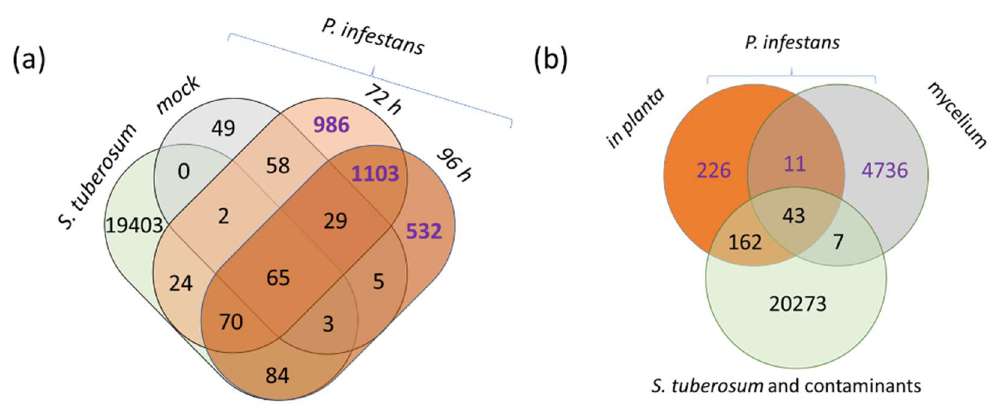
Figure 6. Venn diagram representation of identified peptides in inoculated detached leaves ( a ) and in leaves from the field experiment ( b ). Mock, 72 h and 96 h, in planta, mycelium—peptides found in the search against the P. infestans database in the respective sample group; S. tuberosum— peptides found in the search against the S. tuberosum database and common contaminants database. Purple color-coding indicates peptides unique for P. infestans proteome. See Supplementary Tables S7 and S8 for details.